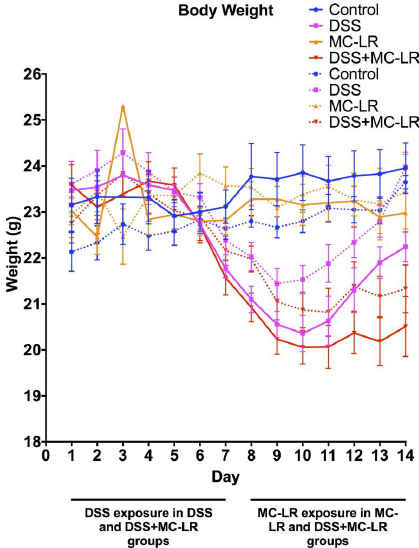
Figure 1. Mouse body weights measured daily throughout the 14-day study. Data presented indicate the mean ± SEM ( n = 6–11 mice per group). Solid lines indicate wild type (WT) mice. Dotted lines indicate CD40KO mice.